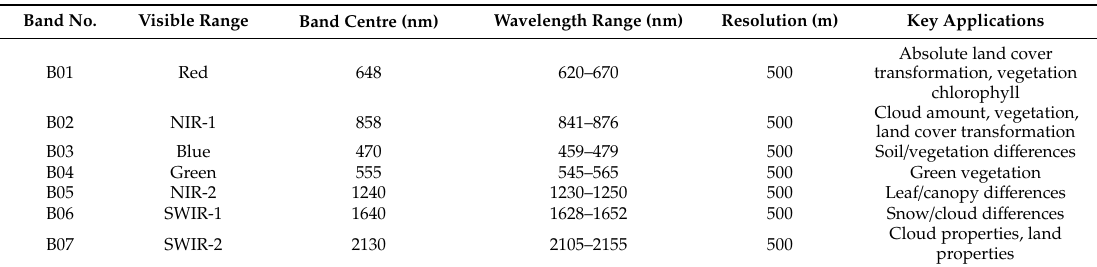
Table 1. Characteristics of the moderate resolution imaging spectroradiometer (MODIS) terra / aqua surface reflectance data [47]. NIR = Near infrared and SWIR = Shortwave infrared. Band No. Visible